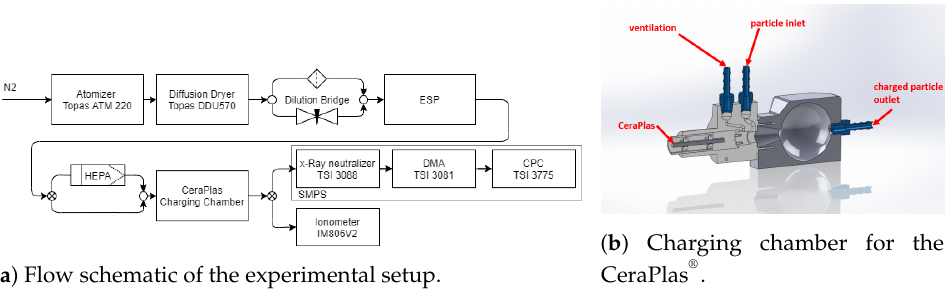
Figure 2. Experimental setup for the feasibility study of the particle charging capability of the CeraPlas ®